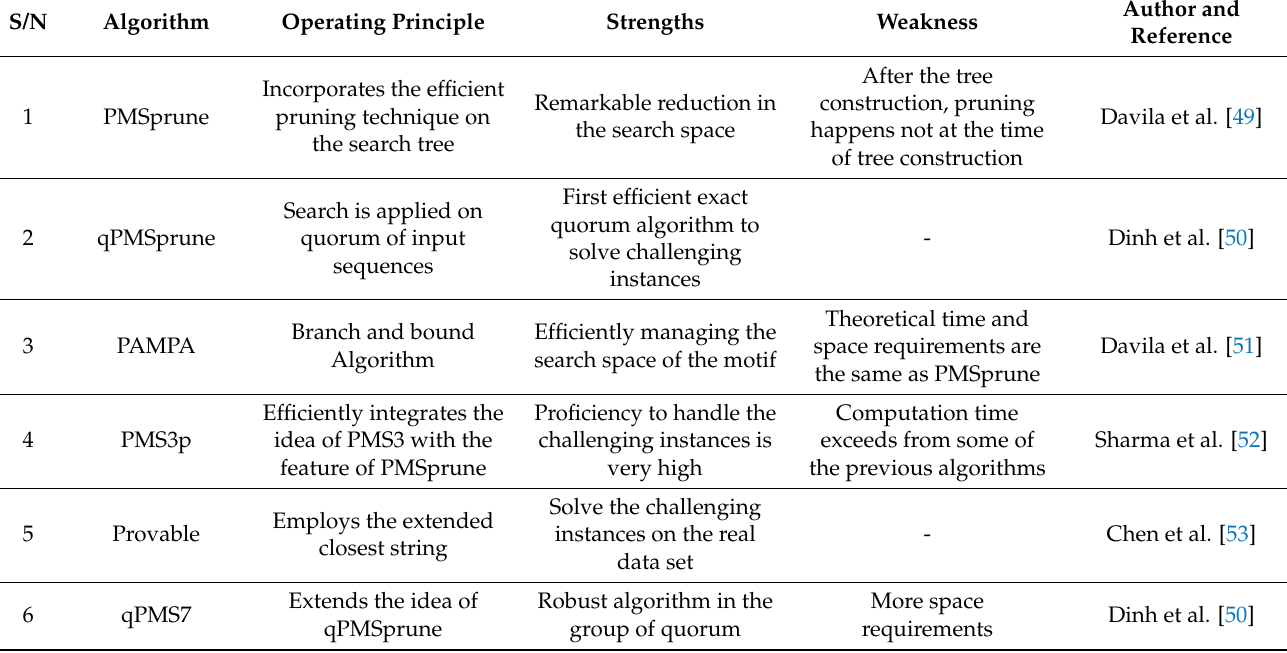
Table A5. List of Exact Motif Discovery Algorithms based Search Tree